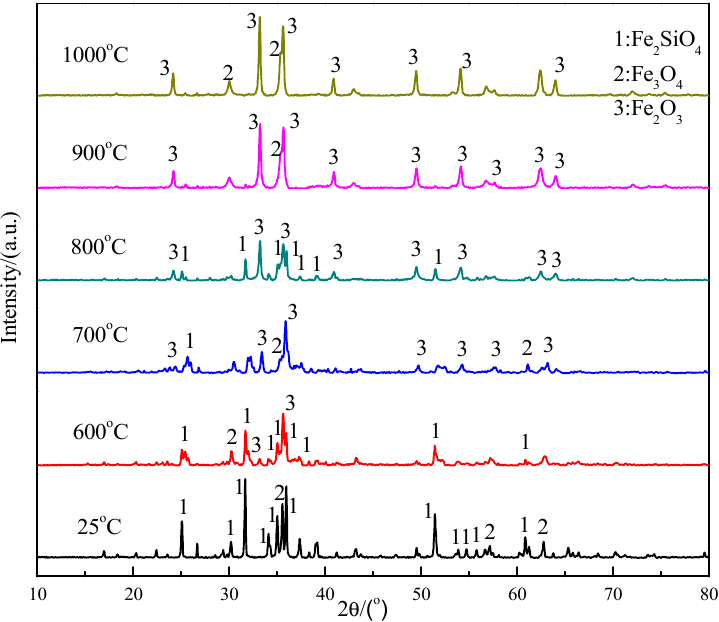
Figure 10. XRD pattern of copper slag in different temperature gradient.